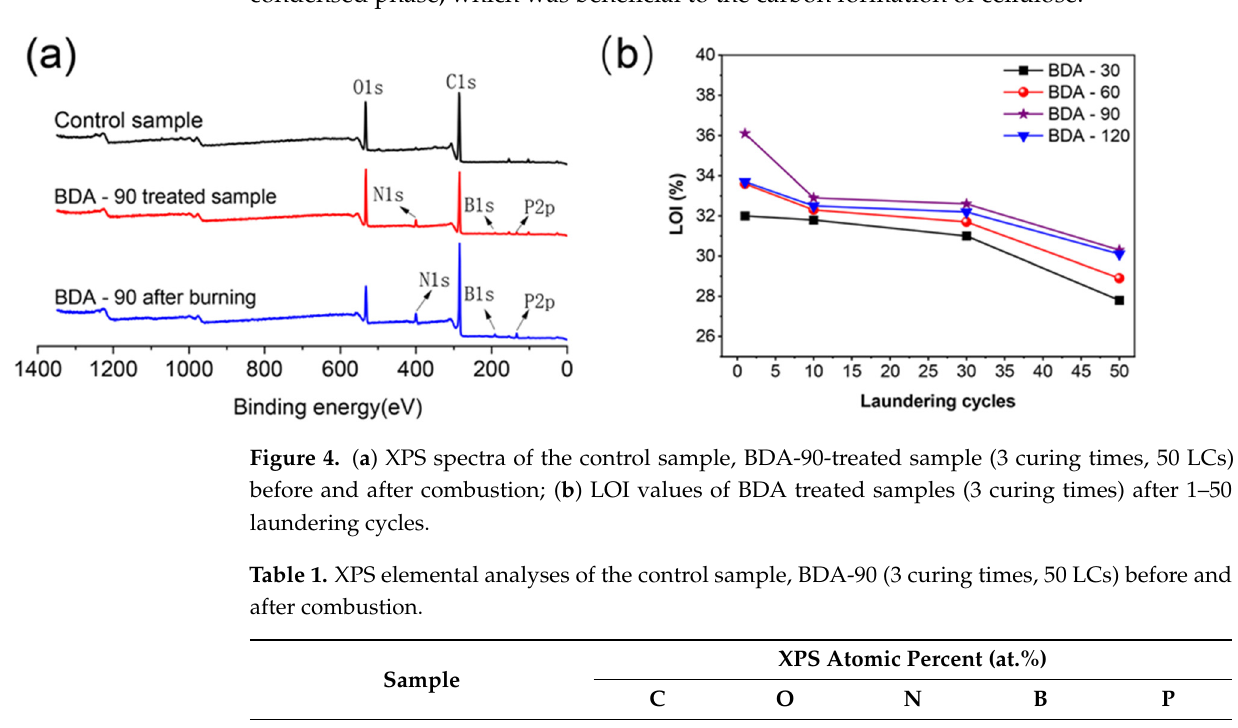
Table 1. XPS elemental analyses of the control sample, BDA ‐ 90 (3 curing times, 50 LCs) before and after combustion.